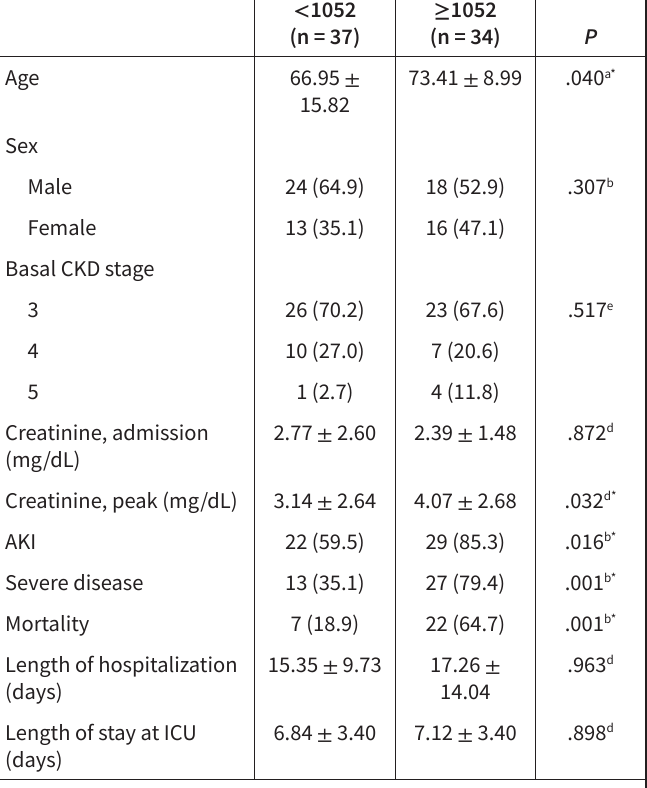
Table 3. Demographic and Clinical Characteristics of the Patients, Stratified by Baseline eGFR